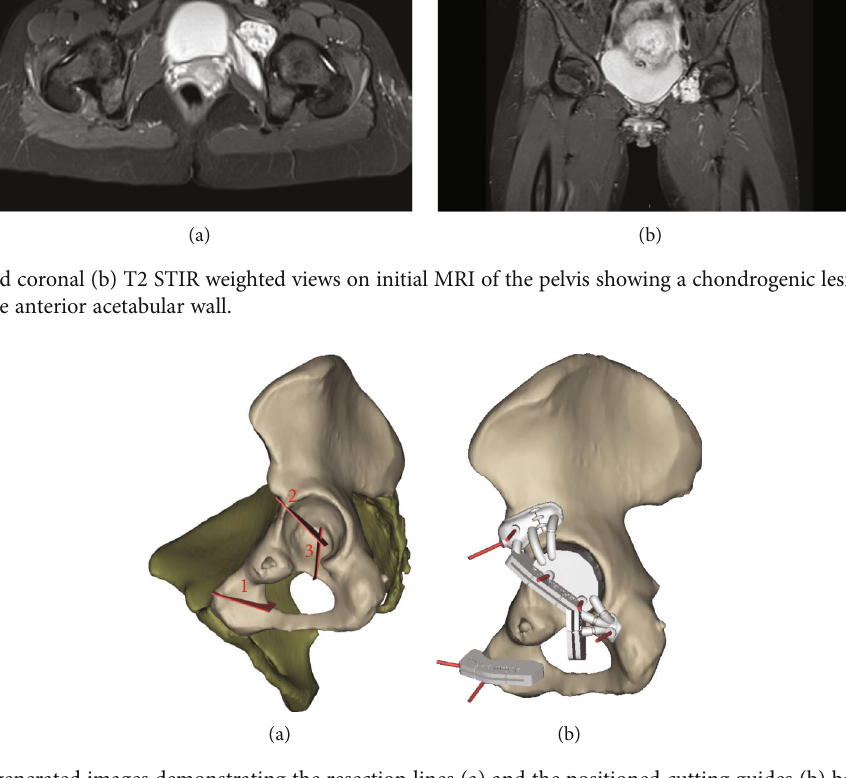
Figure 2: Computer-generated images demonstrating the resection lines (a) and the positioned cutting guides (b) based on MRI- and CT- based reconstructions of the patients ’ hemipelvis. (Images are courtesy of Materialise®, Leuven, Belgium).